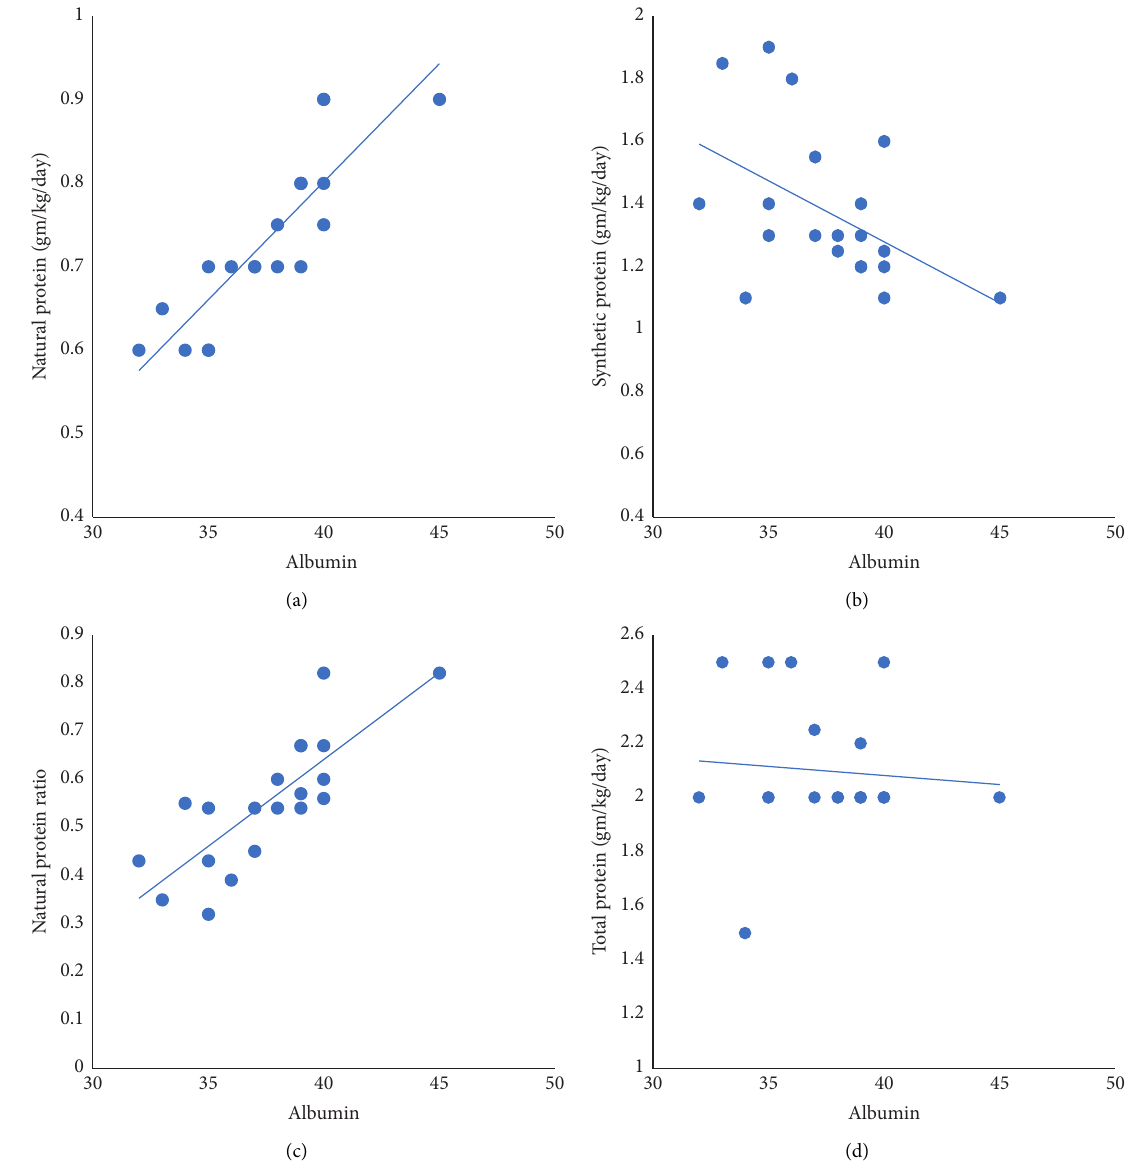
Figure 3: (a) There was a significant positive correlation between the amount of natural protein intake and the albumin level, r � 0.87 and p < 0 . 001. (c) There was also a positive correlation between the ratio of natural protein/synthetic protein in diet and the albumin level, r � 0.80 and p < 0 . 0001. On the other hand, (b) there was a negative correlation between the synthetic protein intake and the albumin level, r � − 0.48 and p � 0 . 031, and (d) no correlation between the total protein and the albumin level, r � − 0.08 and p � 0 . 73. Table 5: Correlation between the percentage of animal protein intake and different growth and nutritional parameters. Height/Length